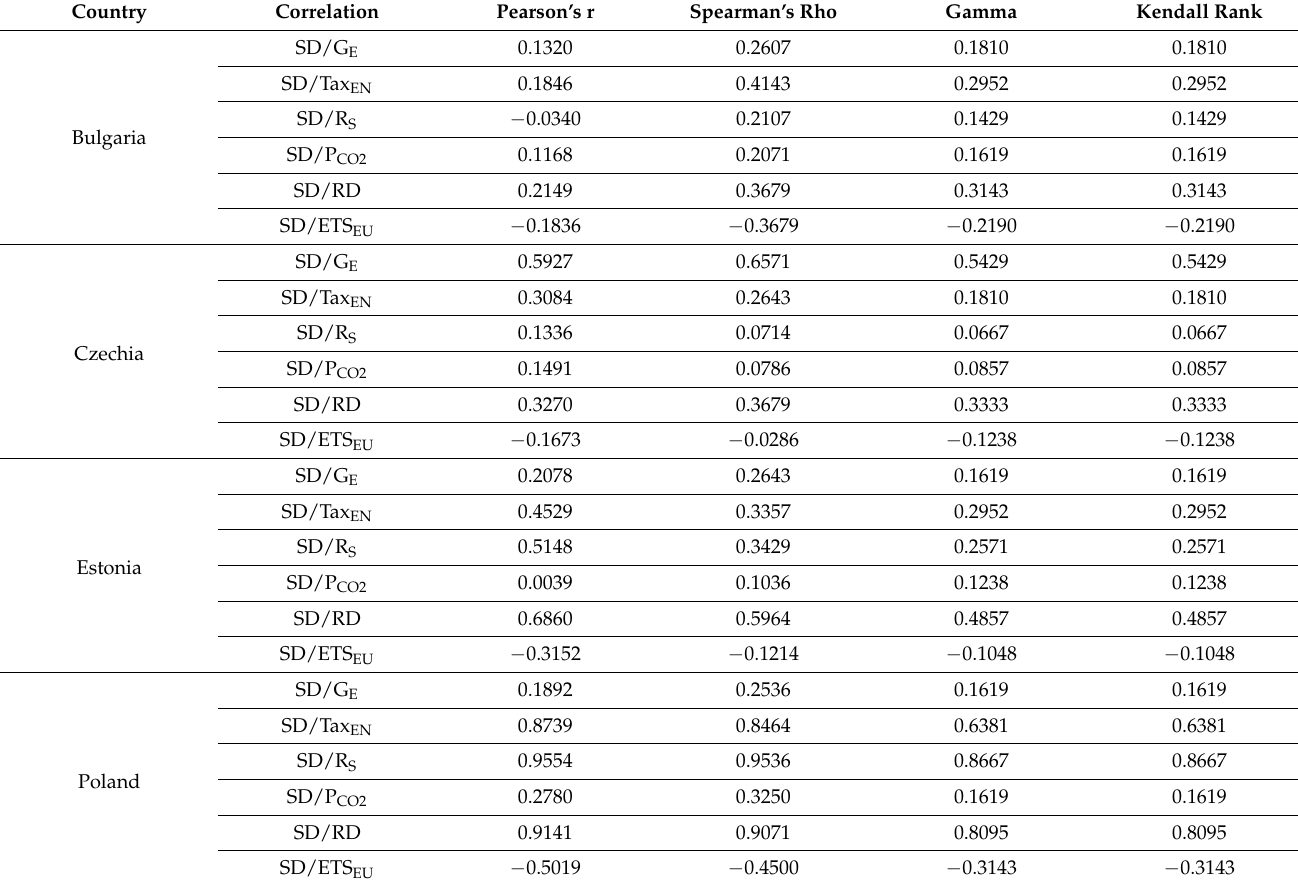
Table 2. Correlation coefficients between sustainable development of energy sector enterprises and selected energy economy factors in the analyzed countries from 2008 to 2022, p < 0.05 (n = 15).